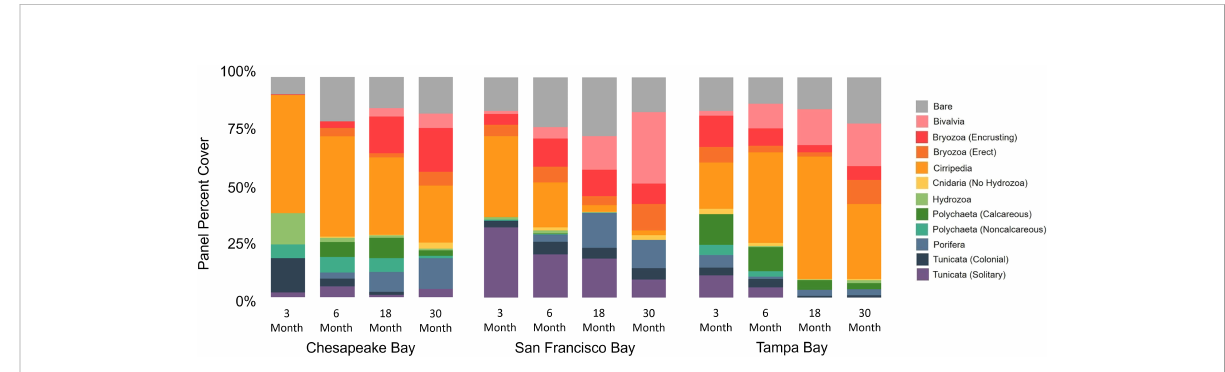
FIGURE 9 Successional average percent cover of major functional groups by increasing soak time across bays. Only panels deployed in period 1 and deployment 1 (see Table 1) are included.